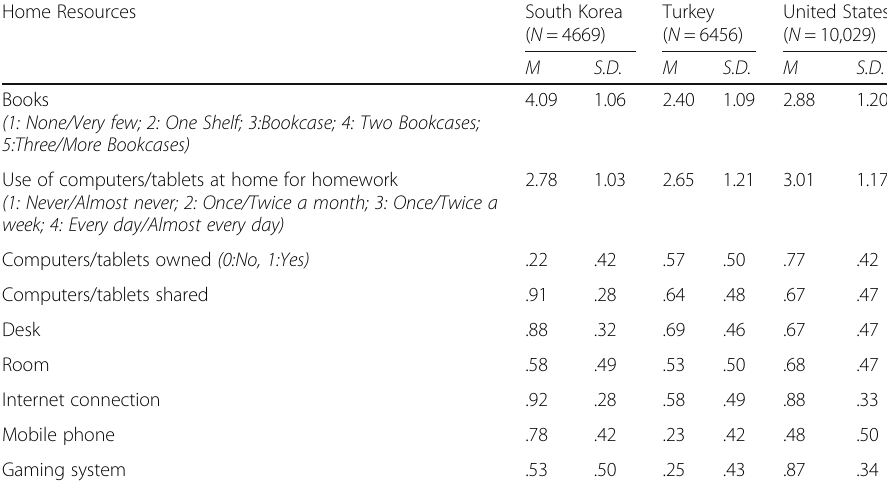
Table 3 Descriptive statistics of fourth graders ’ home resources in South Korea, Turkey, and the United States Home Resources